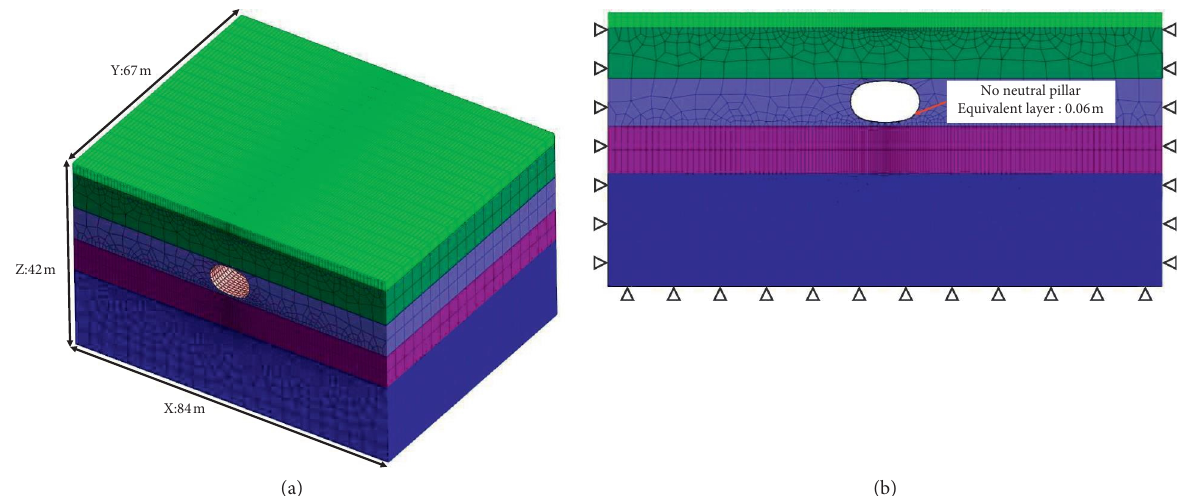
Figure 5: Pipe jacking model size and boundary conditions: (a) Pipe jacking model size. (b) Pipe jacking stratum and boundary condition.